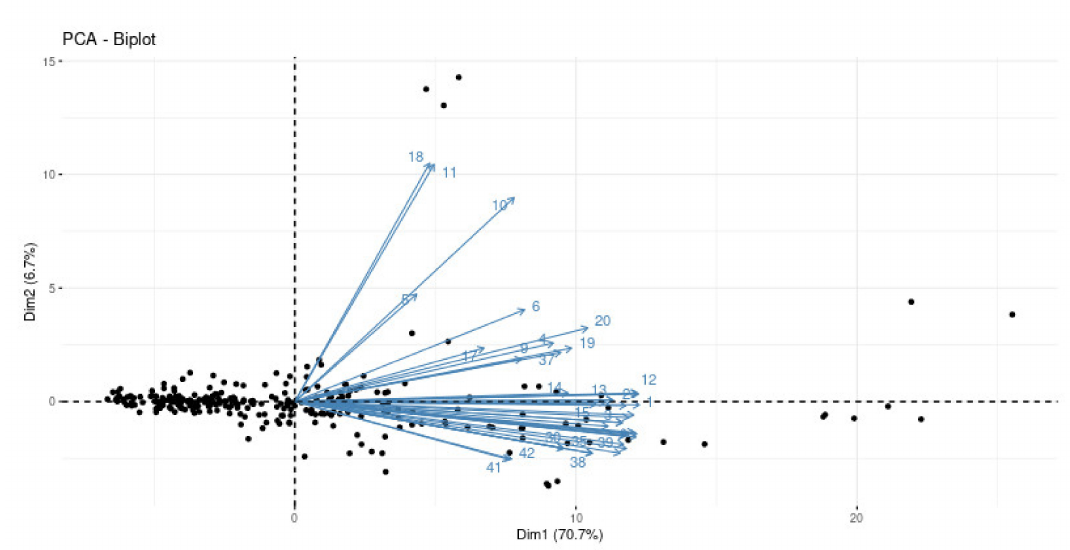
Figure A1. Principal component analysis of environmental impacts: Two main components explain 77.4% of the total variance. 1 = Non renewable fossil and nuclear (MJ eq), 2 = Non renewable fossil (MJ eq), 3 = Non renewable nuclear (MJ eq), 4 = Resources abiotic (kg of Antimony eq), 5 = Resources potassium K (kg), 6 = Resources phosphorus P (kg), 7 = Land competition (m 2 a), 8 = Human digestible protein production potential (kg), 9 = Deforestation (m 2 ), 10 = Total water